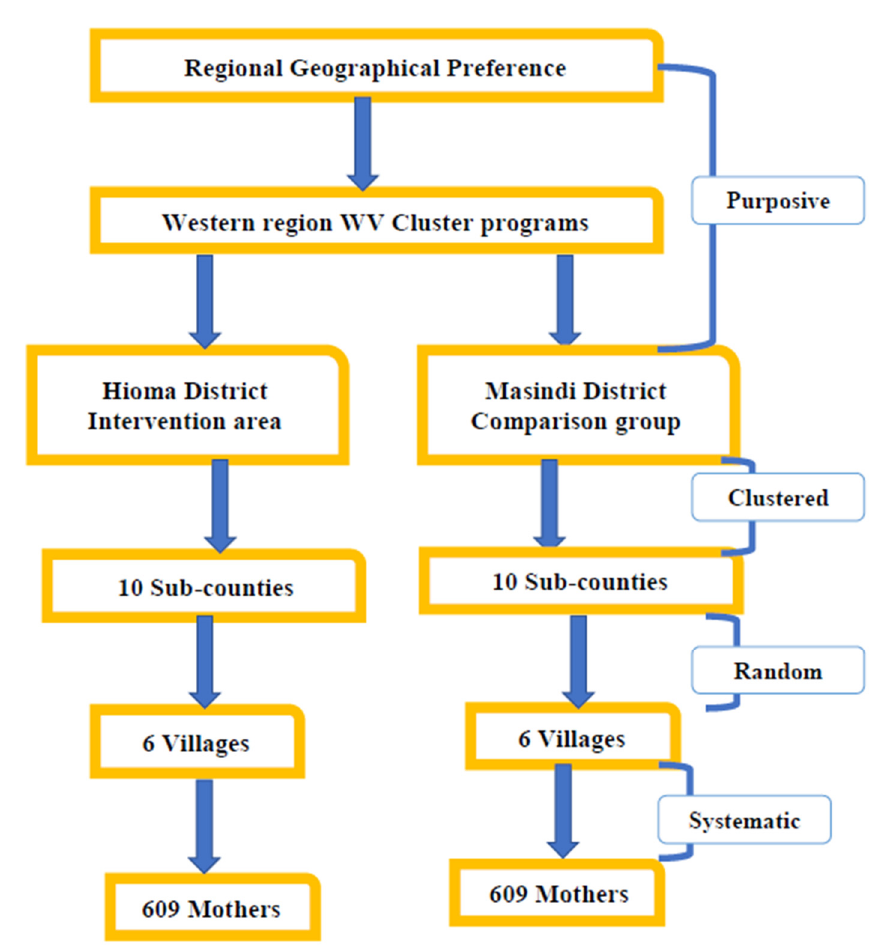
Figure 3. The sampling flow framework.